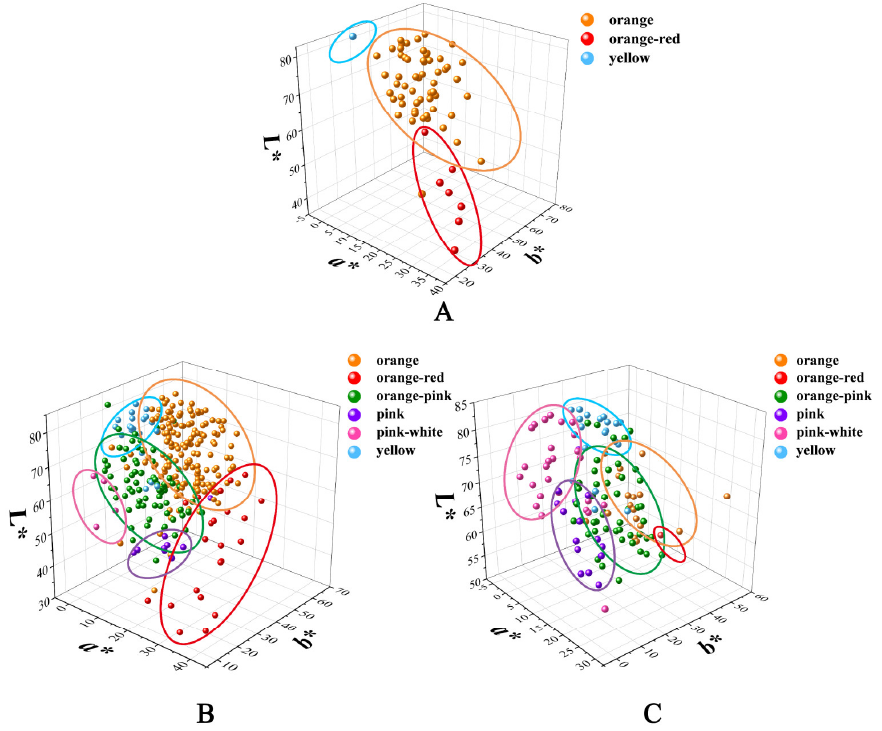
Figure 5. Three-dimensional ( L* , a* and b* ) coordinates of F1 plants in each combination. ( A – C ): F1 plants of EW01, EW02, and EW03, respectively. Horticulturae 2022 , 8 , x FOR PEER REVIEW Table 2. The flower color segregation of F1 plants for three cross combinations. Cross Combina- Pink-White Pink Orange-Pink Orange-Red Yellow Orange tion EW01 0 0